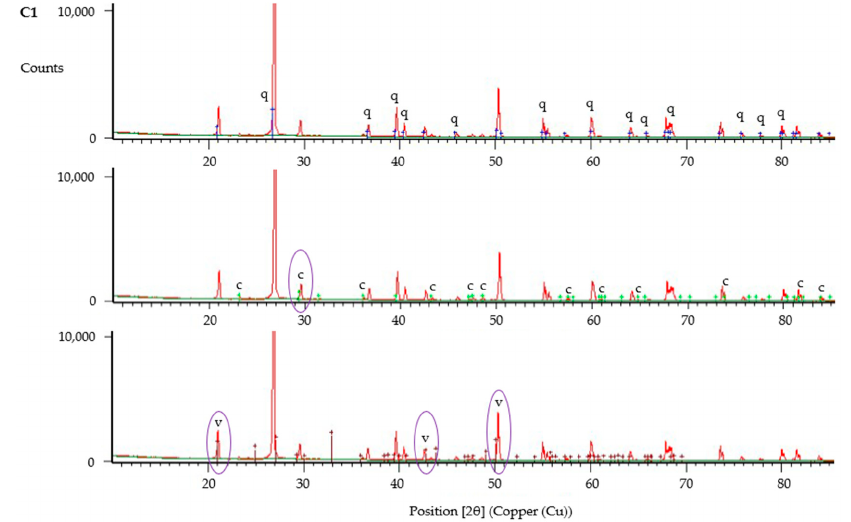
Figure 18. XRD analysis of sample from column C1, showing identified peaks of quartz (q), calcite (c) and vaterite (v).